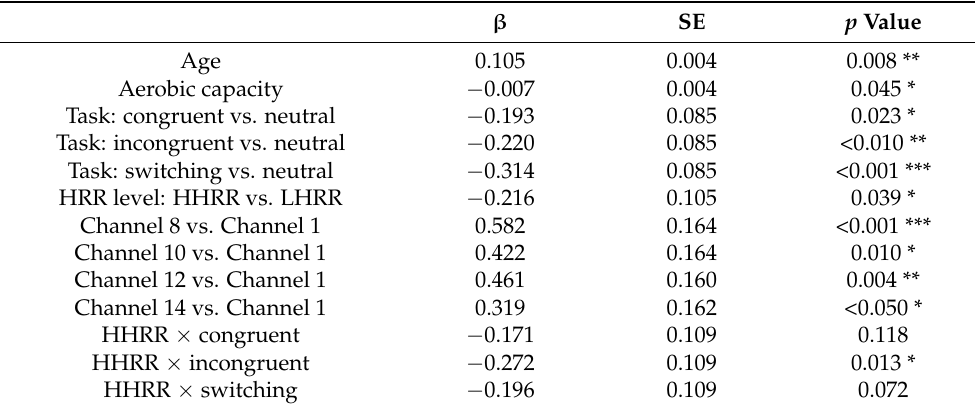
Table 4. Linear mixed effect models with heart rate reserve (HRR) level and Modified Stroop Color Word Test (MSCWT) task conditions as the main effects while controlling for channel, age, and aerobic capacity and Hb as the dependent